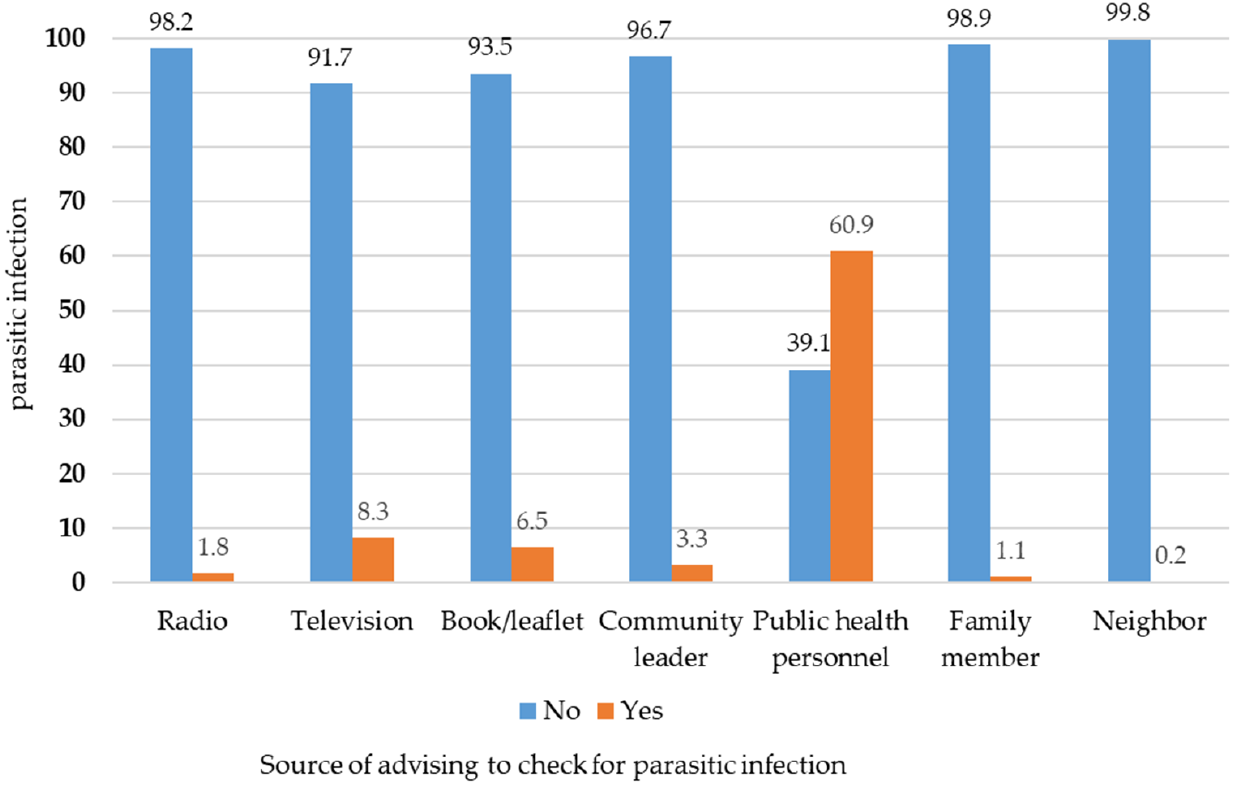
Figure 2. Proportion of respondents who gained knowledge on soil-transmitted helminthiasis by source.